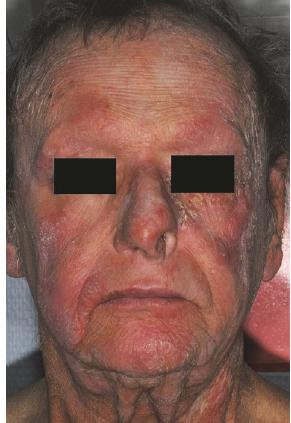
Figure 1: Exophytic lesion of the nose before radiotherapy (front view).